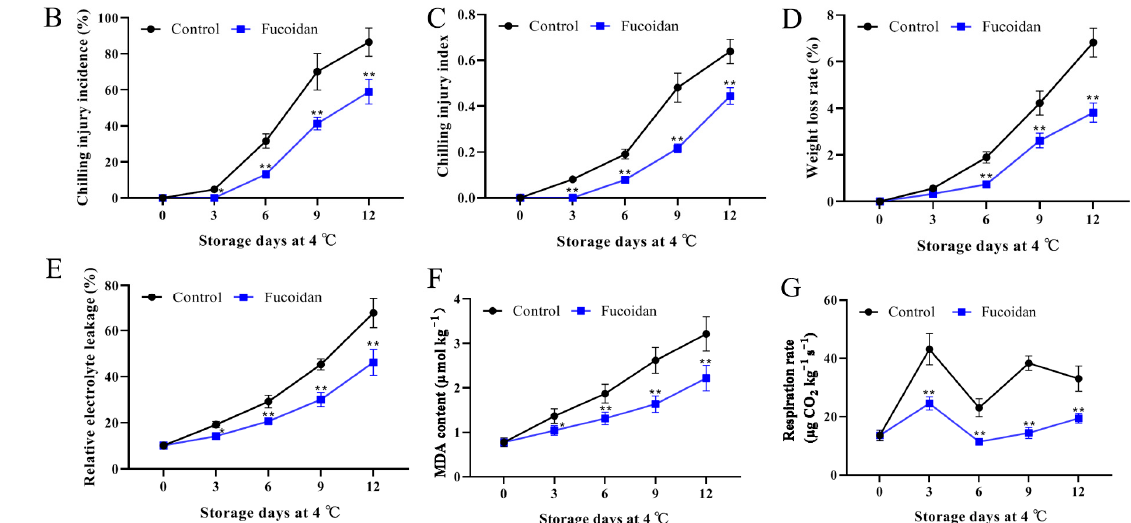
Figure 1. Photograph comparing ( A ), chilling injury incidence ( B ), chilling injury index ( C ), weight loss rate ( D ), relative electrolyte leakage ( E ), MDA content ( F ), and respiration rate ( G ) in cucumber fruit treated with 15 g L − 1 fucoidan during storage at 4 °C. Cucumber fruit treated with distilled water was kept as the control. Values are marked as mean ± standard deviation (SD) of three replicates. The symbol of * and ** express significant differences at p < 0.05 and p < 0.01 between fucoidan-treated and control fruit, respectively.